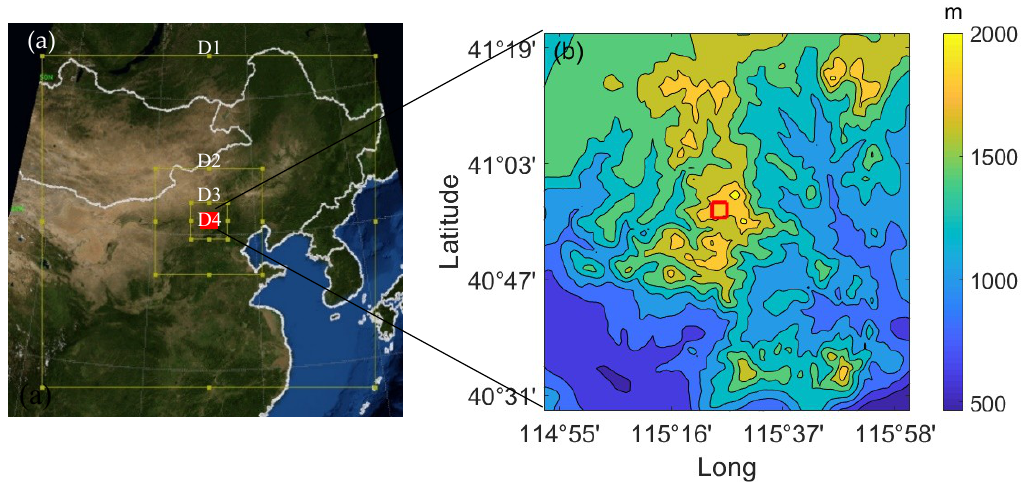
Figure 1. Study area of the Weather Research and Forecasting (WRF) simulation: ( a ) the WRF domain location and configuration around Chongli Montain; ( b ) terrain height in domain D4, and the Computational Fluid Dynamics (CFD) domain configuration (red box).